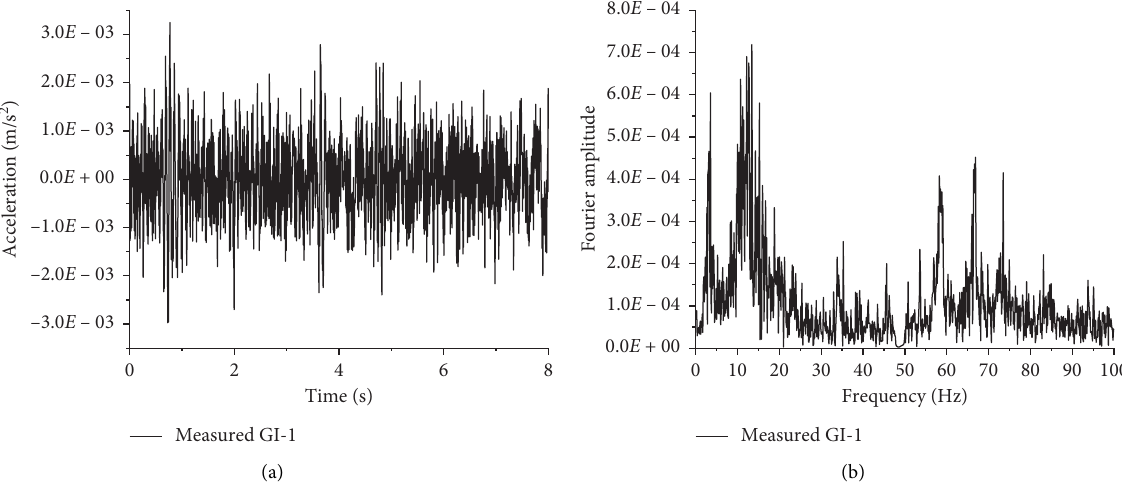
Figure 3: Acceleration: (a) time history and (b) frequency spectrum of GI-1.